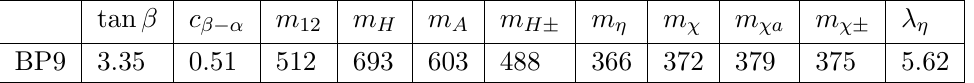
was varied such that the mass di(cid:11)erence was (cid:12)xed to a